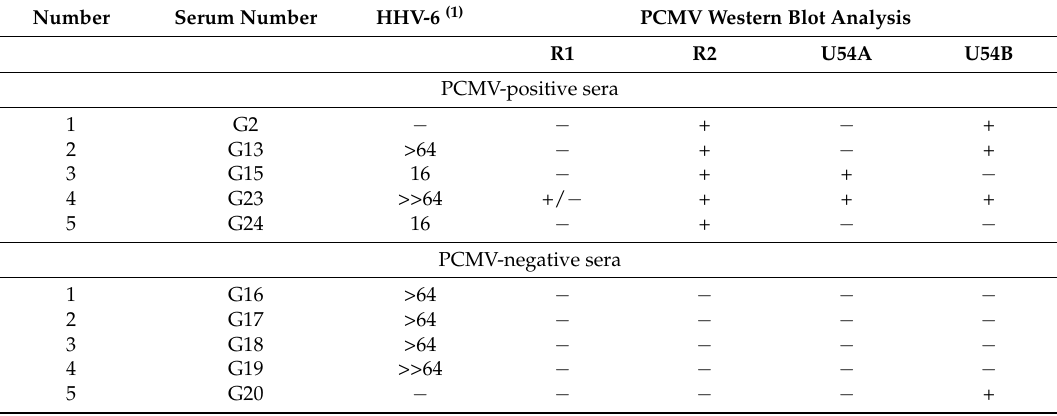
Table 5. Testing human sera for PCMV and HHV-6 by Western blot analysis and immunofluorescence